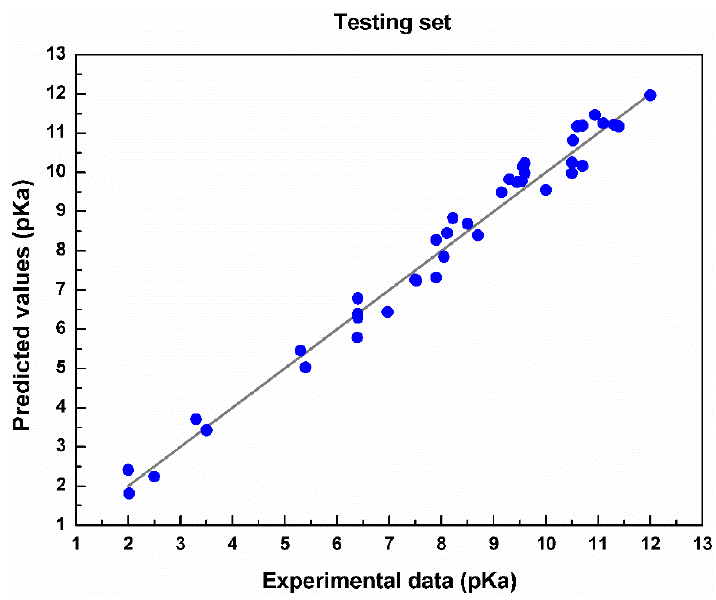
Figure 3. Comparison between the predicted and experimental values in the testing set. Table 4. Statistics of the model prediction performance. AARD : Absolute average relative deviation. RMSEP : Root mean square error of prediction. R 2 : Squared correlation coefficient.